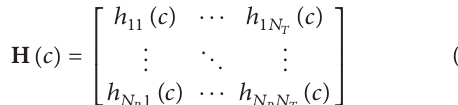
Figure 5: Attenuation of the decomposed PLC-MIMO channel of Figure 3.